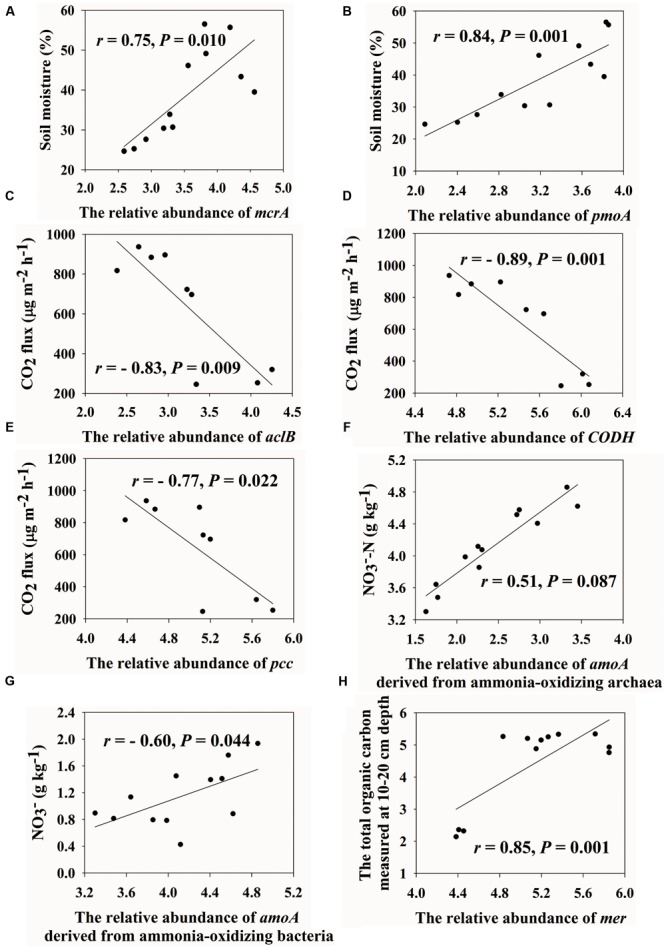
Correlations between soil moisture and the relative abundance of mcrA
(A) and pmoA
(B), CO2 flux and the relative abundance of aclB
(C), CODH
(D) and pcc
(E), nitrate and the relative abundance of amoA drived from ammonia-oxidizing archaea (F) and bacteria (G) and the total organic carbon measured at 10–20 cm depth and the relative abundance of mer (H). Pearson correlation and TDIST tests were used to calculate r and P values, respectively.